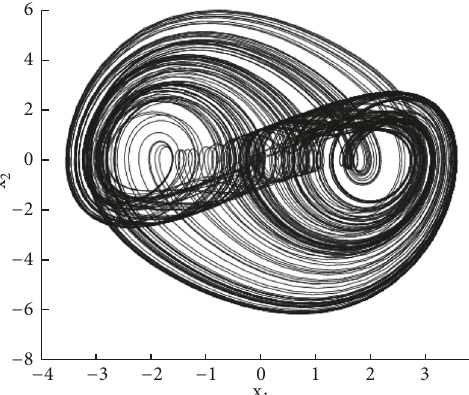
Figure 2: State response of x 1 of Arneodo system.